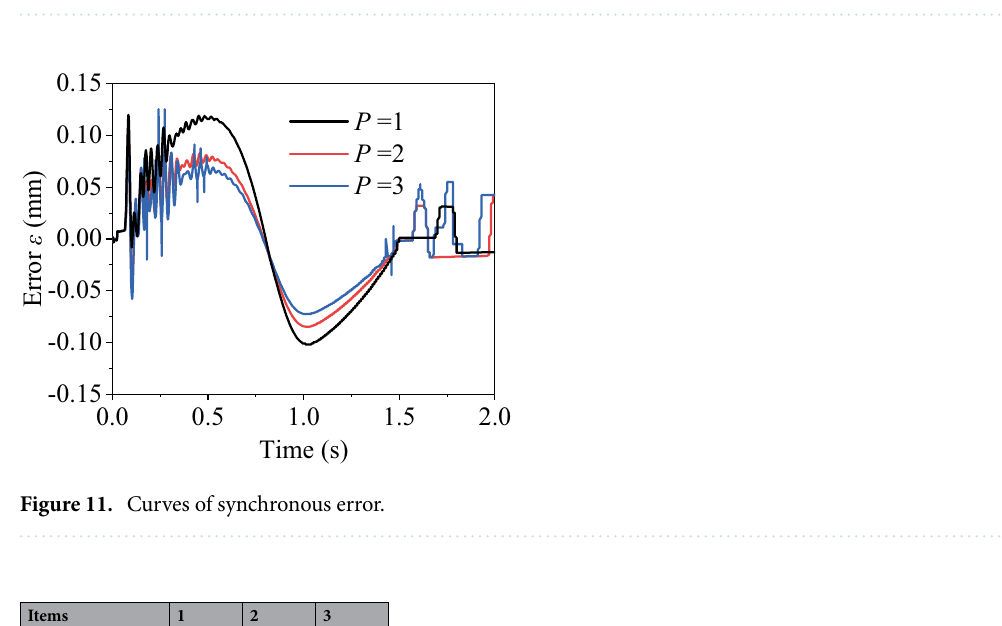
Figure 10. Block diagram of synchronous control with equivalent cross-coupling correction.